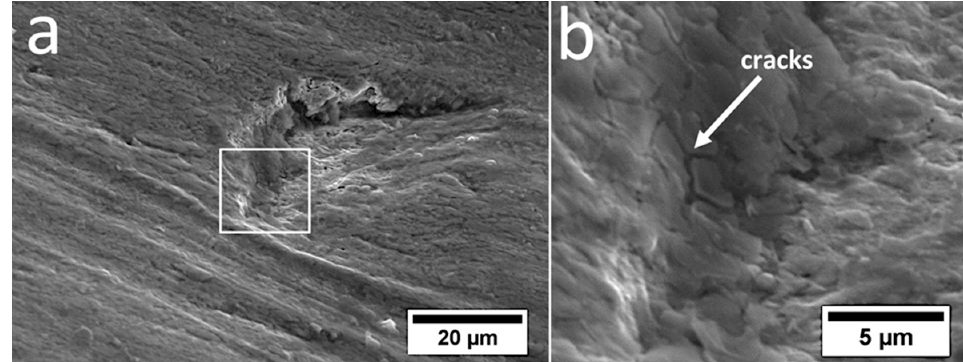
Figure 13. ( a ) Pit caused by primary chromium carbide spalling. ( b ) Visible microcracks in the pit area. Scanning electron microscopy.